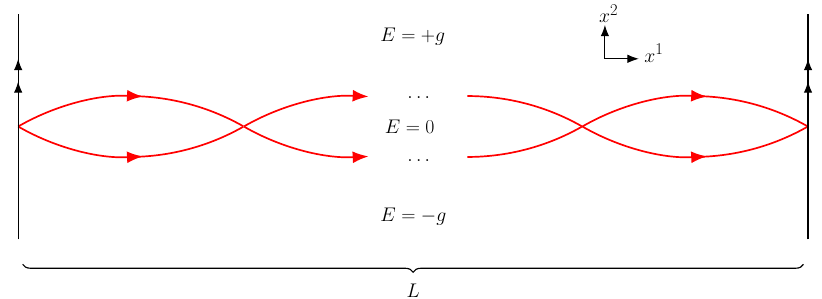
Figure 17. A possible “chain instanton” contributing to h + g | − g i .